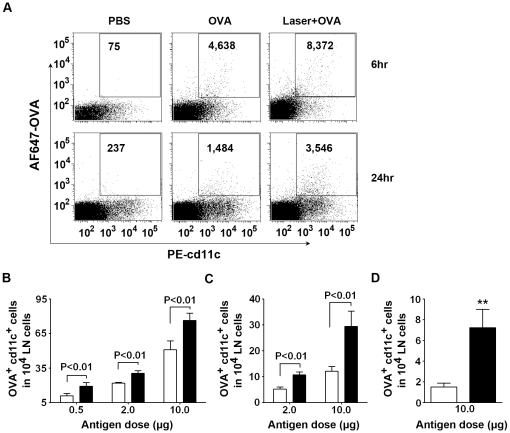
Laser increases Ag-uptake by DCs in the draining lymph node.
A. Representative flow cytometry profiles showing the number of OVA+CD11c+ cells. Single cell suspensions were prepared from the draining LN (inguinal) after 6 or 24 hrs of laser illumination and i.d. injection of 10 µg AF647-OVA. The cells were stained with anti-CD11c antibody and analyzed as Figure 3. The absolute numbers of CD11c+OVA+ cells were given in the profile in one million cells counted. B and C. An increase in the number of Ag-captured DCs in the 1° draining LNs. The cells were prepared from the inguinal LN at 6 hr (B) or 24 hr (C) after laser illumination and AF647-OVA injection at the indicated dose and analyzed as above. Data are means ± SEM of absolute numbers of CD11c+OVA+ cells in 104 LN cells from draining lymph nodes analyzed as A. n = 6; blank bar, AF647-OVA alone and black bar, laser + AF647-OVA. D. An increase in the number of Ag-captured DCs in the 2° draining LN at 24 hrs after 10 µg AF647-OVA was i.d. administered. The cells isolated from the ipsilateral axillary LN were analyzed and the data were expressed as above.